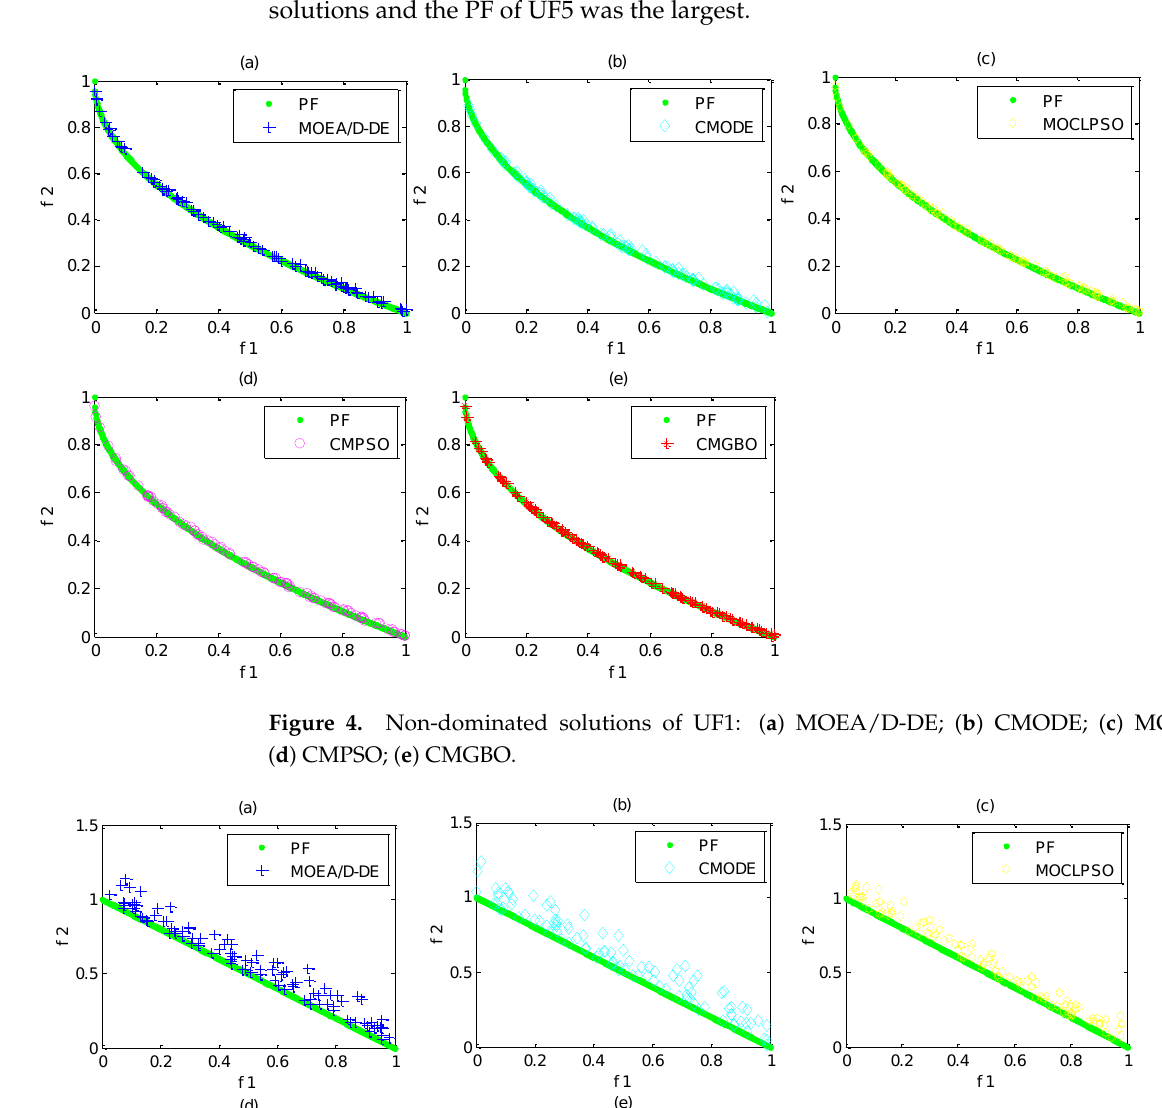
Figure 5. Non-dominated solutions of UF5: ( a ) MOEA/D-DE; ( b ) CMODE; ( c ) MOCLPSO; ( d ) CMPSO; ( e ) CMGBO.